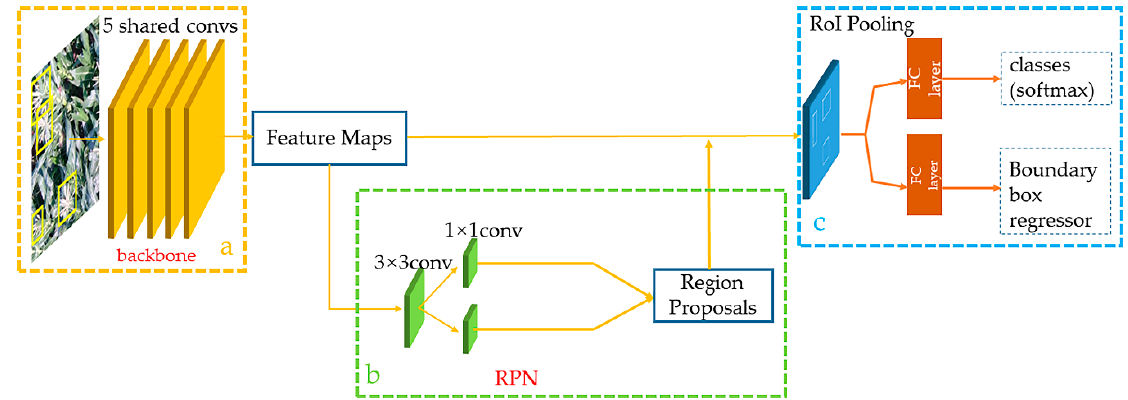
Figure 3. ( a ) The algorithm generates feature maps through five shared convolutional layers in a given annotated image. ( b ) The region proposal network (RPN) determines whether the object is foreground or background and processes the first bounding box regression and ( c ) these region proposals are classified and corrected after RoI pooling.